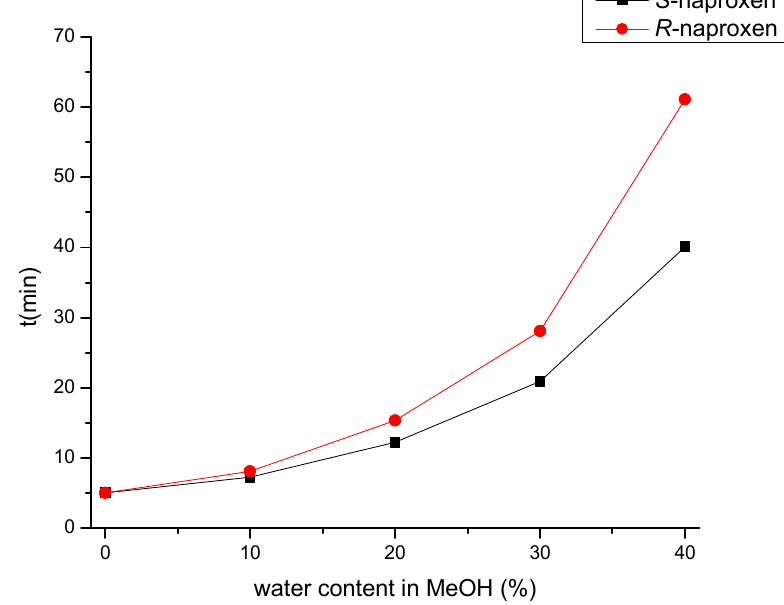
Figure 4. Retention profile of naproxen enantiomers in MeOH:water mixture on the Lux Amylose-1 column. All mobile phases contain uniformly 0.1% ( v / v ) acetic acid. Chromatographic conditions: flow rate: 0.5 mL/min, column temperature: 25 °C, detection at 230 nm.